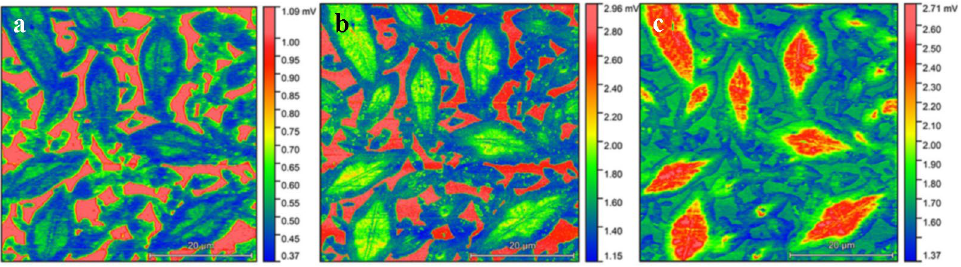
Figure 2. AFM-IR images at fixed wavelengths. AFM-IR mapping at ( a ) 1080 cm −1 ( b ) 1262 cm −1 and ( c ) 1376 cm −1 . Here, red, green and blue areas indicate high, medium and low concentrations, respectively. Field of view 50 × 50 µm 2 .